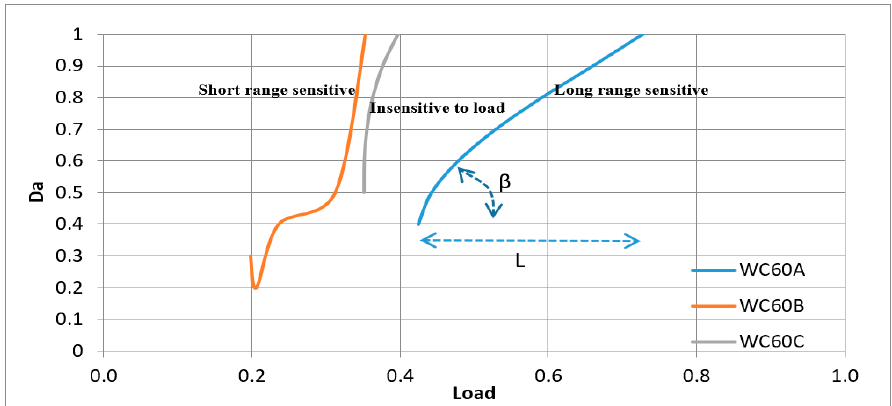
Figure 11. Sensitivity of parameter (Da) A3 for WC60A, B and C from the ANN simulation.